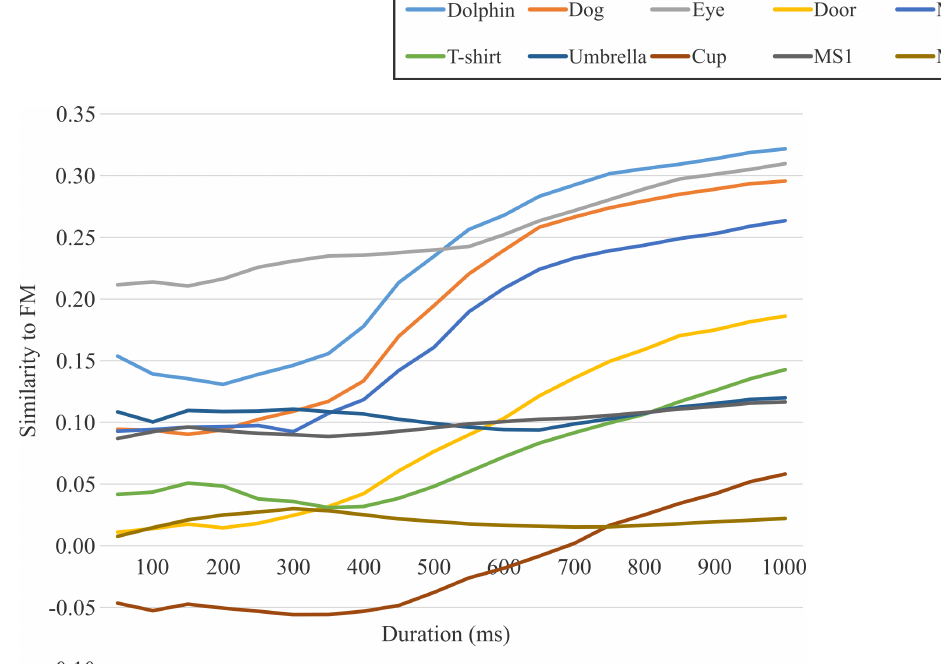
Figure 8. Similarity transitions within 1 s in